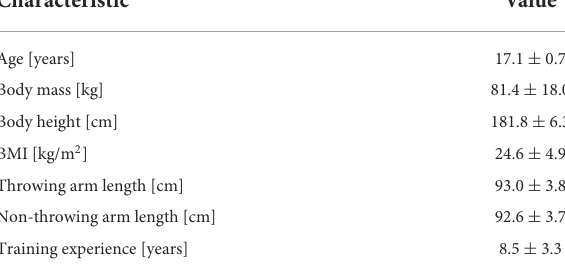
TABLE 1 Characteristics of the study participants ( N =